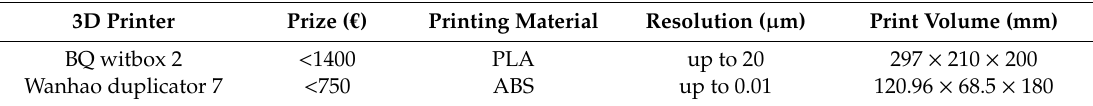
Table 1. Technical specifications of the 3D